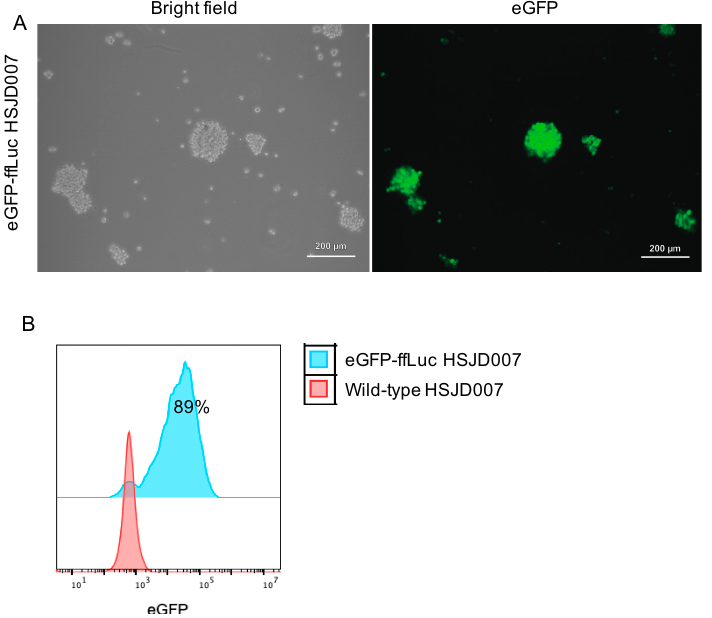
Figure 3. Patient-derived DIPG neurospheres were examined for GFP expression 96 h after lentiviral transduction. ( A ) Fluorescence microscopy of patient-derived DIPG neurospheres 96 h after infection after lentiviral transduction showing bright field ( left ) and fluorescence ( right ) images. ( B ) Flow cytometry analysis of patient-derived DIPG neurospheres (HSJD007) after lentiviral transduction. Proportions of HSJD007 expressing eGFP (blue) were detected using flow cytometry 96 h following lentiviral vector transduction compared to wild type counterparts